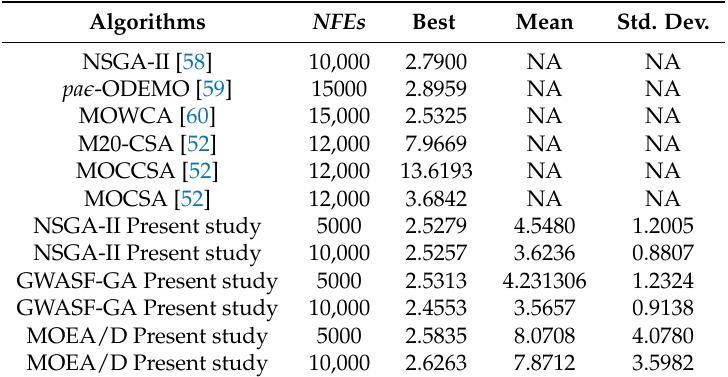
Table 2. Comparison and statistical results of the best objective cost, mean and standard deviation, respectively, found by different MOEAs (NA, not available).